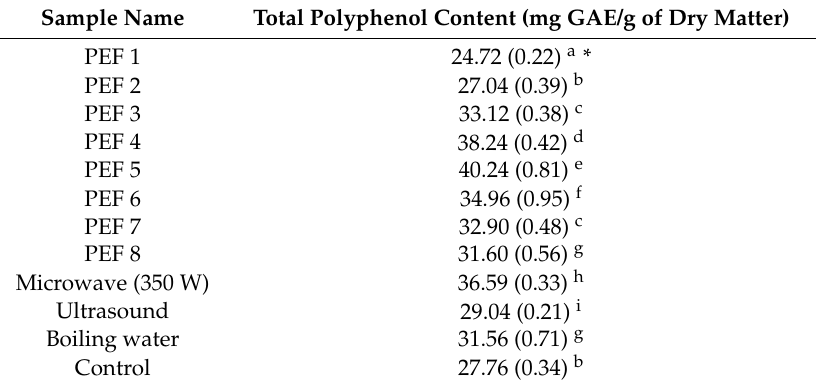
Table 2. Total polyphenol content of the